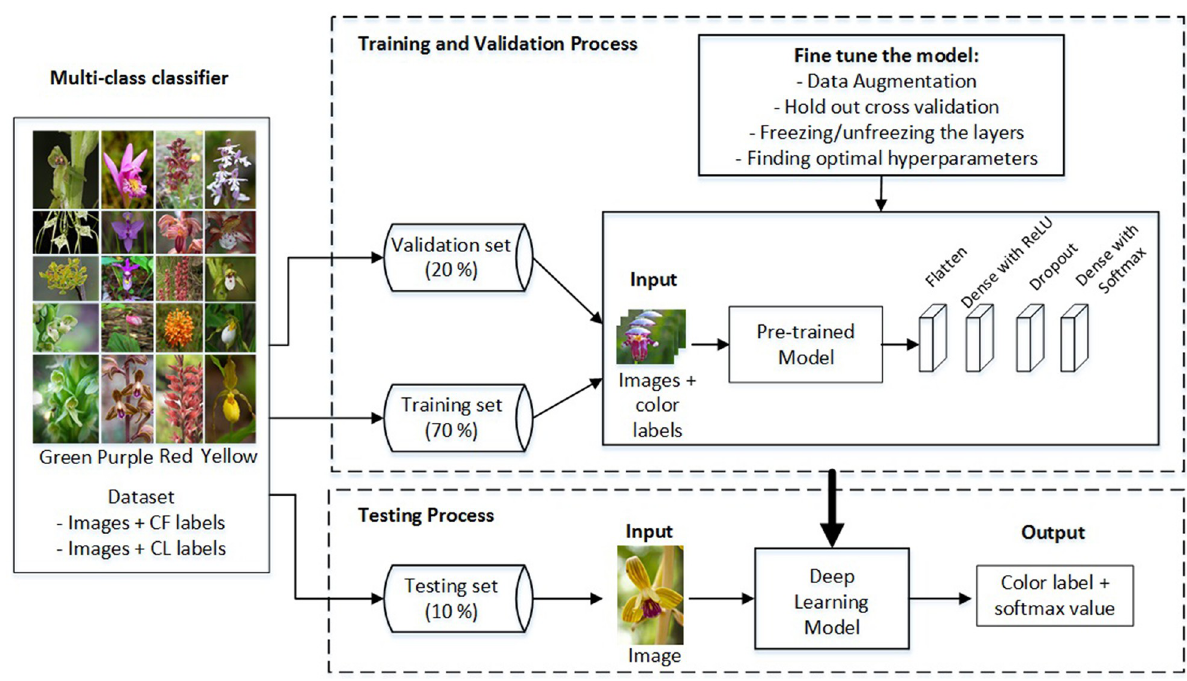
Fig 7. Multi-class